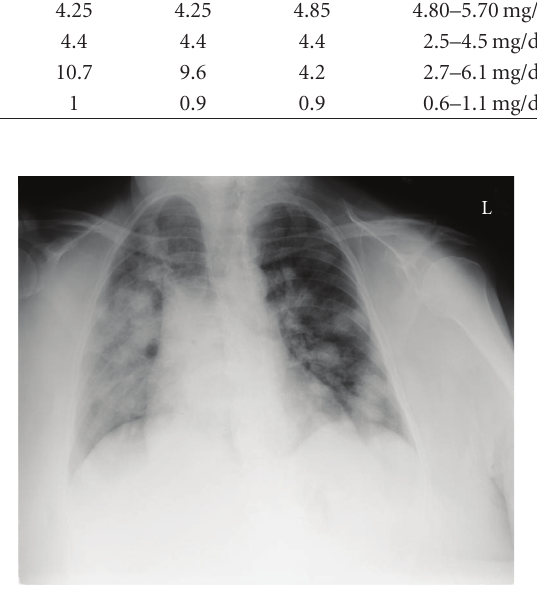
Figure 1: Chest X-ray showing multiple pulmonary